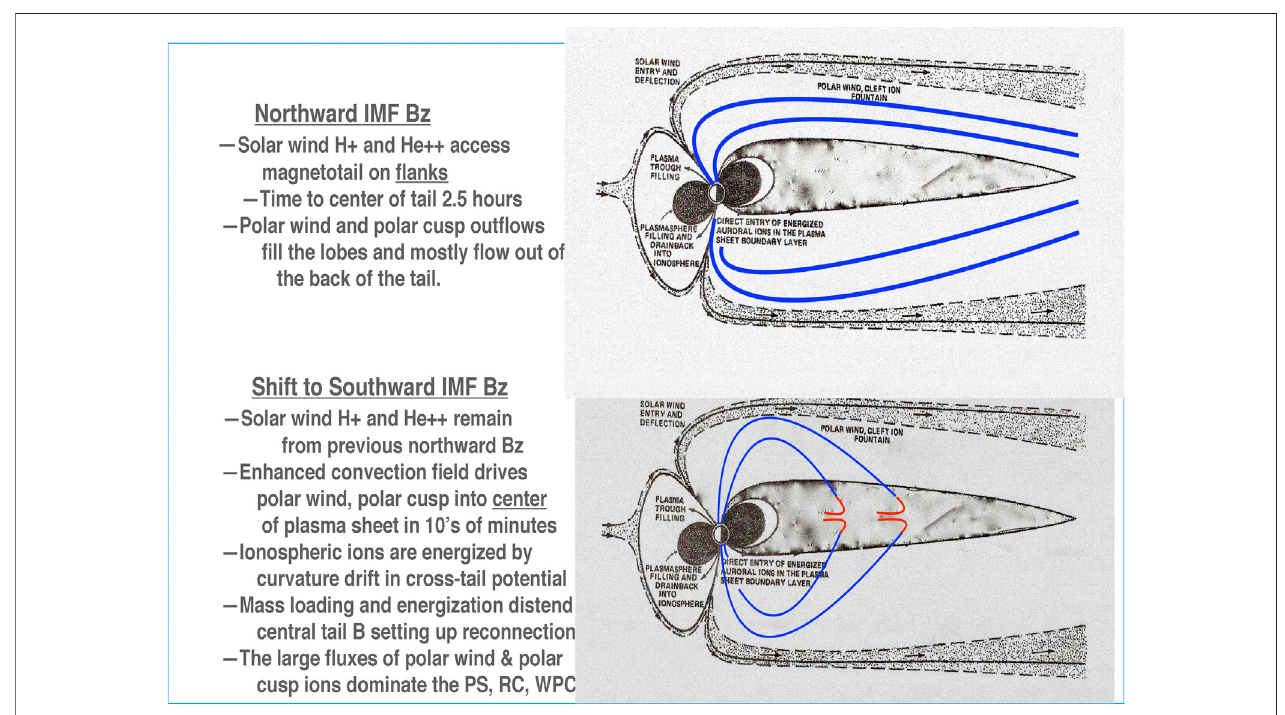
FIGURE15 | Twosketches which give aschematic picture ofthe suggested process by which ionospheric and solarwind plasma access the magnetospheric tail and through which the ionosphere can be a dominant plasma source and a driver of magnetospheric storms and substorms.